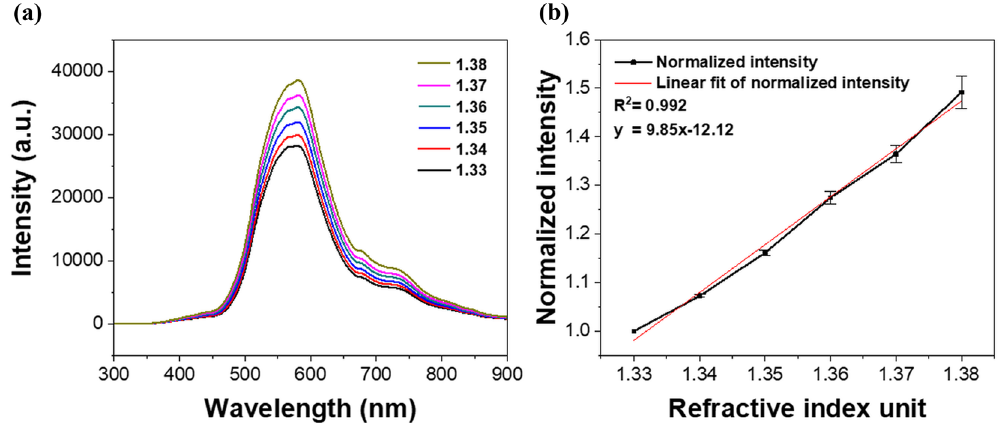
Figure 2. Refractive index characteristics of proposed sensor chip: ( a ) response of FO LSPR sensor for various refractive indices and ( b ) changes of LSPR intensity at 640 nm; all points are normalized by 1.33.